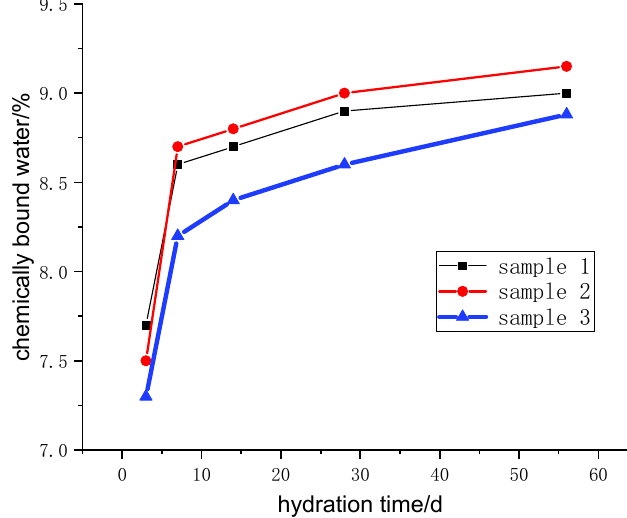
ff erent curing